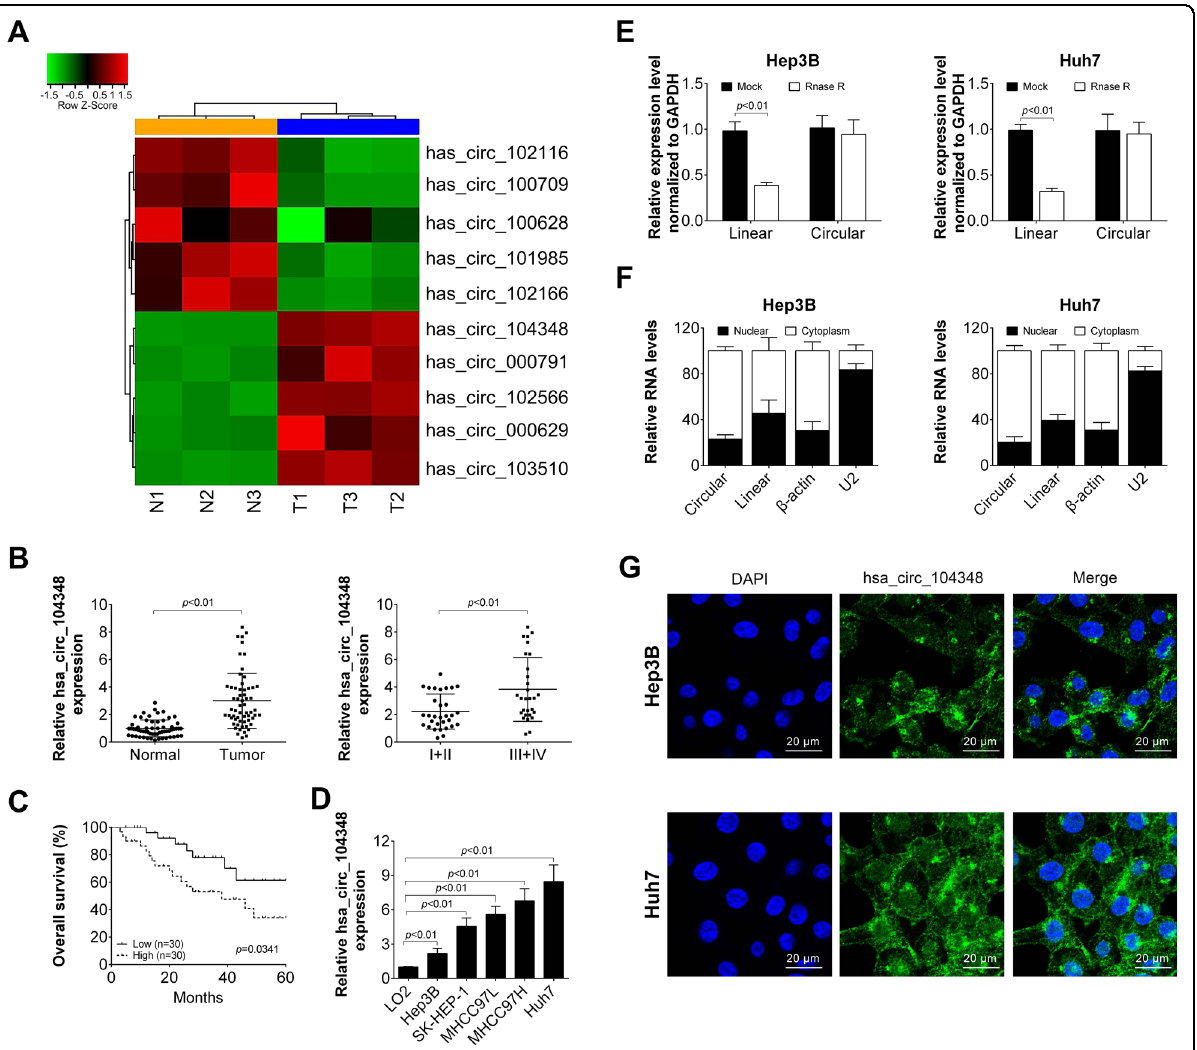
overall survival rate. D The expression of has_circ_104348 was detected in HCC cell lines (Hep3B, SK-HEP-1, MHCC97L, MHCC97H, Huh7) and normal liver cells (LO2) by qRT-PCR. E ELMO1 mRNA and circular has_circ_104348 were detected, RNA samples were treated with RNase R or mock